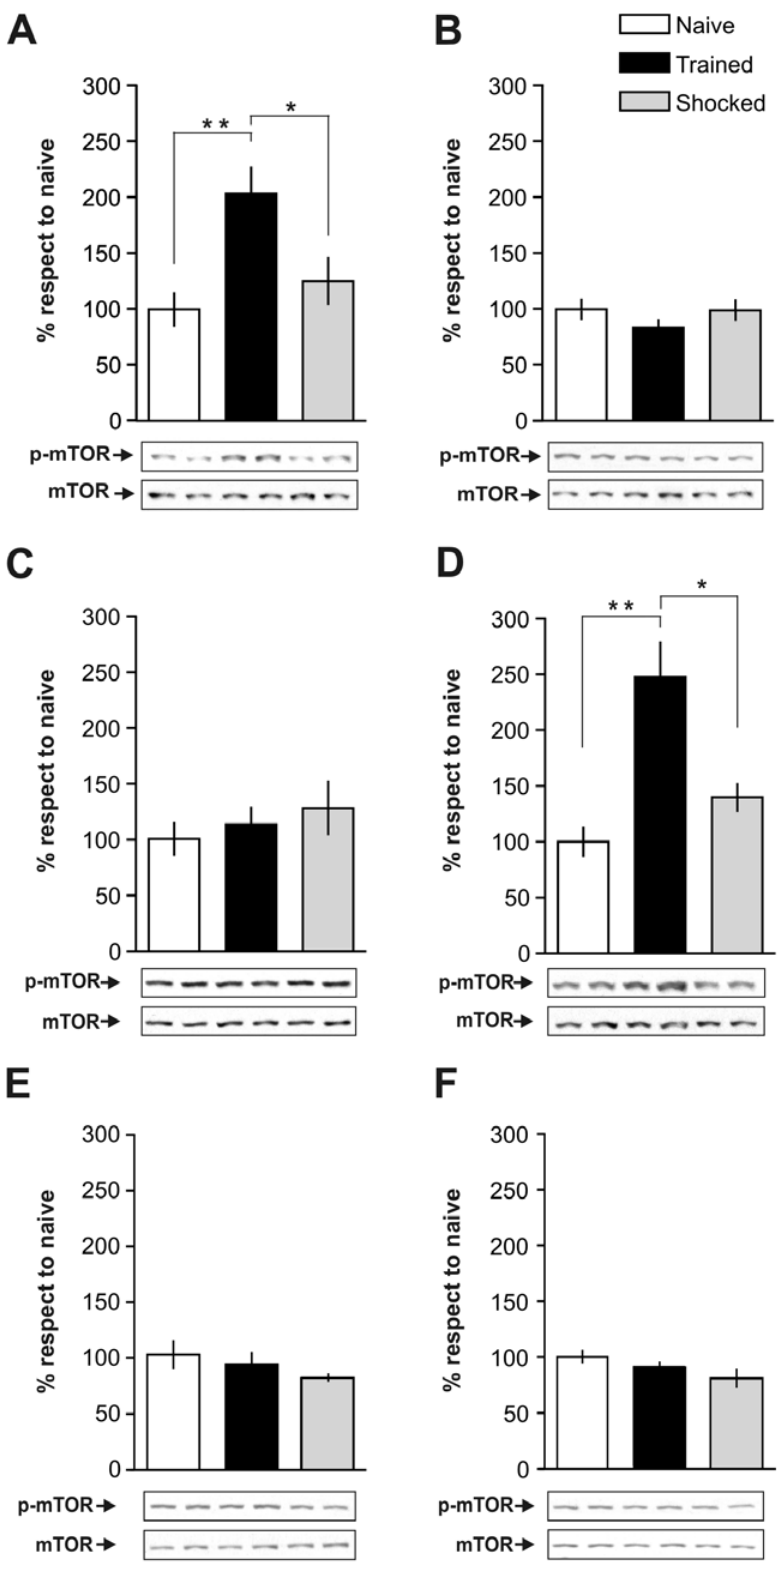
Figure 1. IA Training Is Associated with Two Time Windows of mTOR Activation in the Hippocampus. Bars represent the mean p-mTOR/ mTOR ratio of trained (black) or shocked (gray) groups respect to naı¨ve (white) group, sacrificed immediately (A), 15 min (B), 1 h (C), 3 h (D), 9 h (E) or 12 h (F) after IA training. Data are expressed as means 6 SEM of p-mTOR/mTOR ratio; *p , 0.05, **p , 0.01. Representative blots of phosphorylated and total protein levels of mTOR are shown in the lower panels. n=5–6 per group for each experiment. doi:10.1371/journal.pone.0006007.g001 PLoS ONE |